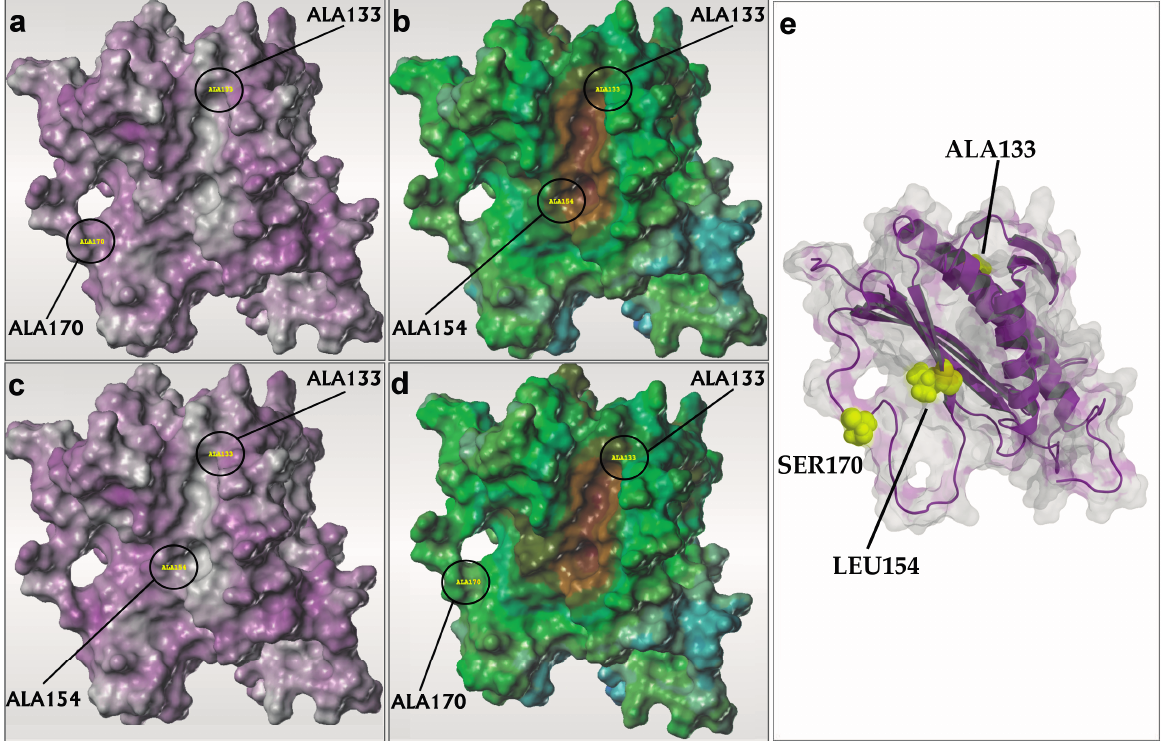
Figure 3. ( a , c ) The distribution of hydrogen bond acceptor (purple) and donor (grey) features on the water accessible surface area of Mad2 R133A/S170A (pCR exp = 4.31) ( a ) and Mad2 R133A/L154A (pCR exp = 4.37) ( c ); ( b , d ) The distribution of hydrophobic (brown) and hydrophilic (green) features on the water accessible surface area of Mad2 R133A/L154A (p K d(Cdc20)exp = 5.91) ( b ) and Mad2 R133A/S170A (p K d(Cdc20)exp = 7.09) ( d ); and ( e ) The backbone from the template structure used for modeling Mad2 mutants (Protein Data Bank code: 1S2H [17]) is represented as a purple ribbon with the same orientation as the models of Mad2 mutants presented in ( a – d ). The residues that present substitutions are represented with yellow spheres and are labeled